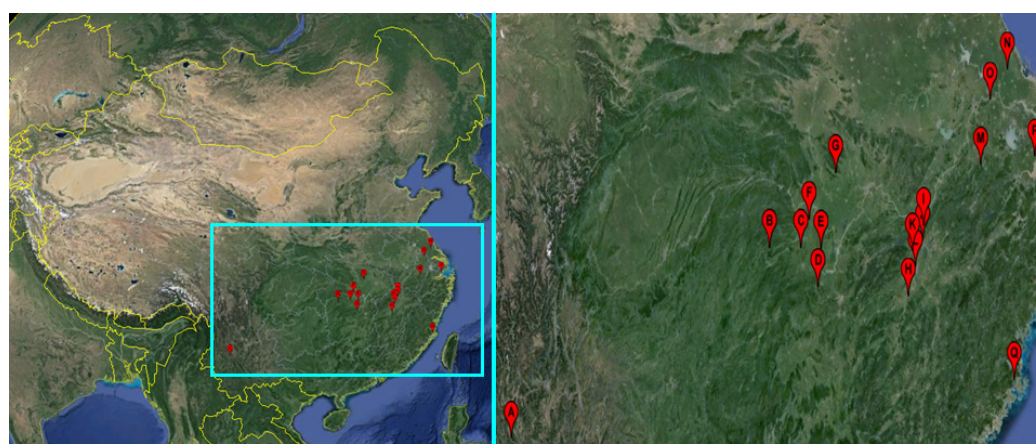
Figure 1. The sampling sites of Oncomelania hupensis snails in